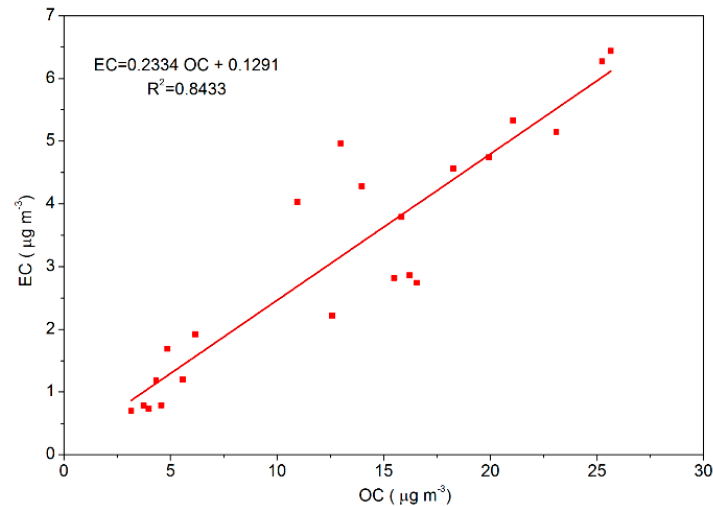
Figure 2. Correlation analysis between Elemental Carbon (EC) and Organic Carbon (OC) in Beijing during the heating season in 2016. during the heating season in